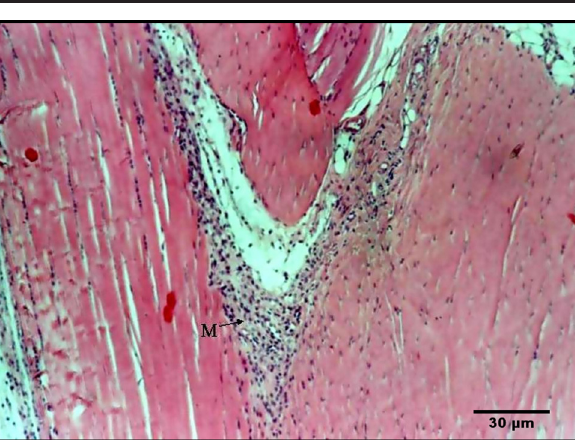
FIGURE 3 - Photomicrograph stained with hematoxylin-eosin, showing concentration of macrophages (M) in group G2 animals (malnourished and treated for 7 days). 100X magnification.